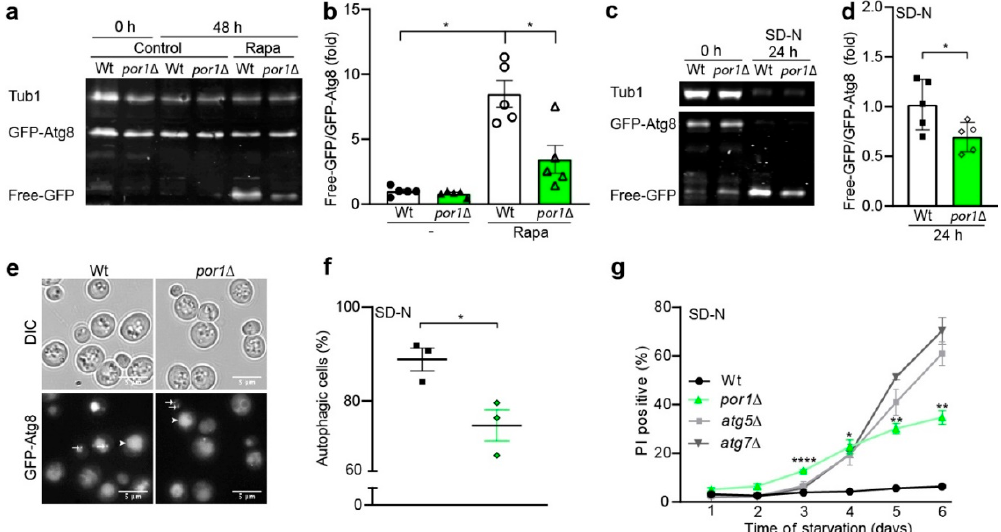
Figure 2. por1 Δ cells showed reduced autophagic capacity upon rapamycin treatment or nitrogen starvation. ( a , b ) POR1 deletion reduces the autophagic capacity at 48 h on SD medium upon rapamycin treatment, as shown by GFP–Atg8 liberation. A representative immunoblot is depicted in ( a ) and free-GFP/GFP–Atg8 ratios are quantified in ( b ). The immunoblots were probed with GFP- and tubulin-specific antibodies. Specific signals are normalised to wildtype ( n = 5). ( c – f ) Autophagy induction by nitrogen starvation is reduced in por1 ∆ at 24 h. A representative immunoblot of wildtype (Wt) and por1 ∆ cells before (0 h) and after shift to nitrogen starvation media (24 h) is depicted in ( c ) and free-GFP/GFP–Atg8 ratios are quantified in ( d ). Immunoblot signals are normalised to wildtype ( n = 5). Representative micrographs of GFP–Atg8-expressing wildtype and por1 ∆ cells are depicted in ( e ) and GFP–Atg8-positive vacuoles (autophagic cells) are quantified in ( f ) ( n = 3, with n > 279 quantified cells per biological replicate). ( g ) POR1 deletion increases levels of cell death on nitrogen starvation, as assessed by PI staining and flow cytometry ( n = 4). PI-positive fractions of wildtype (Wt), por1 ∆ , atg5 ∆ , and atg7 ∆ cells are plotted in line diagrams showing mean ∆ SEM. Statistical analysis was performed with GraphPad Prism using Welch’s ANOVA in ( b ), Welch’s t -test in ( d ), unpaired t -test in ( f ), and 2-way ANOVA in ( g ). Error bars indicate standard error of the mean (SEM) and asterisks in the figures indicate significant differences, * p < 0.05, ** p < 0.01, **** p <